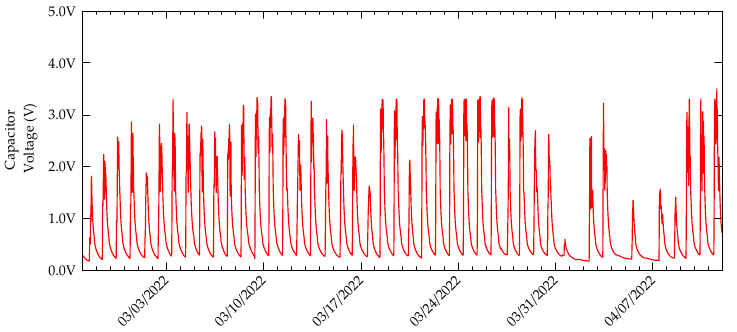
Figure 12. Voltage across C STORE recorded in every one minute for the whole duration of the